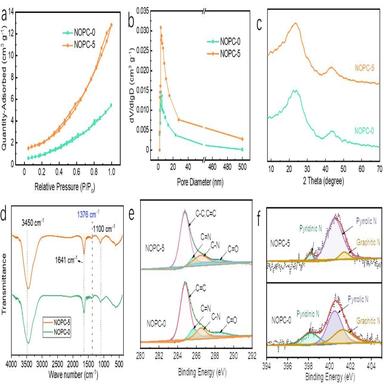
(a) Nitrogen adsorption isotherms at 77 K, (b) pore size distribution of different samples. (c) XRD, (d) FT-IR spectra, and normalized (e) C 1s, and (f) N 1s core levels of different samples.